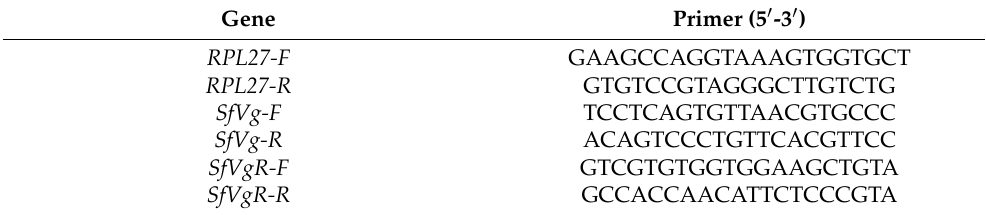
Table 2. Primers for RT-qPCR.